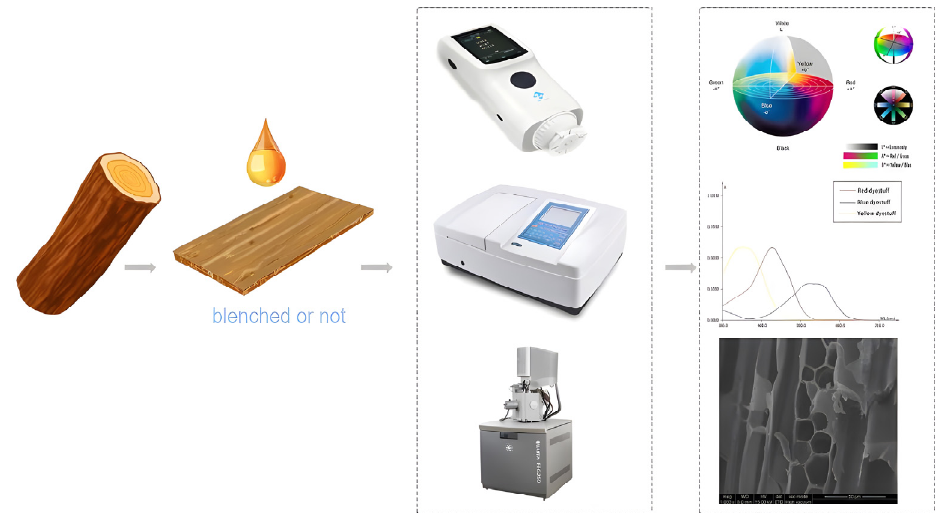
Figure 1. Experimental flow chart [26].